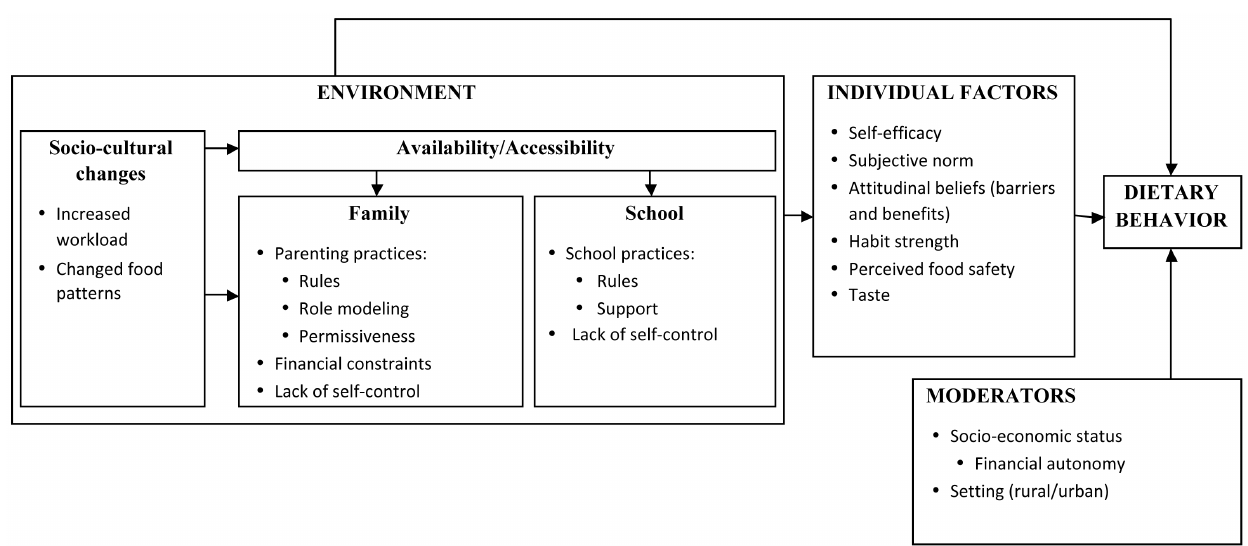
Figure 1. Conceptual framework for eating behavior in Ecuadorian adolescents.